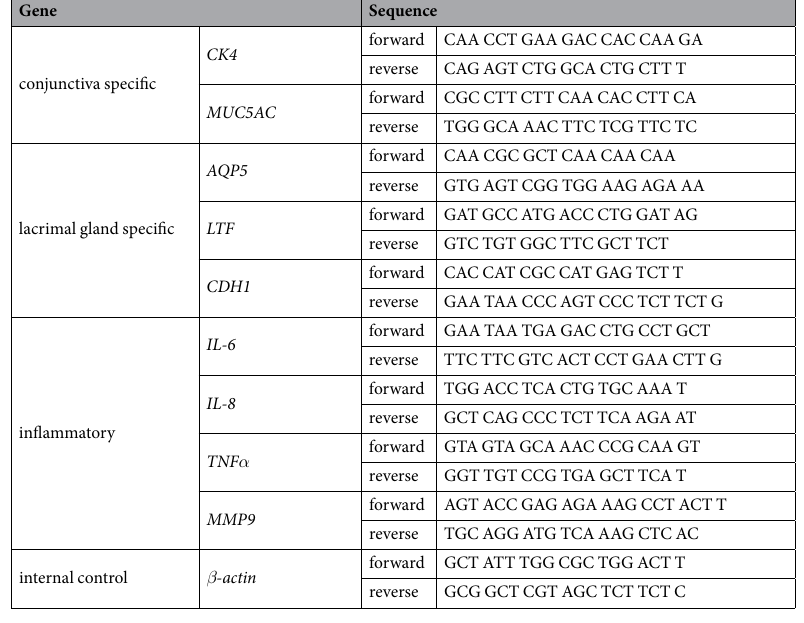
Table 1. Primer sequences for